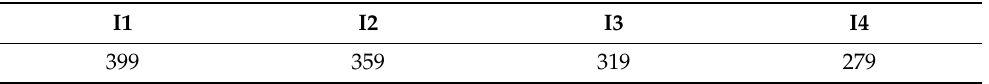
Table 2. Seasonal water consumption (mm) for tomatoes cultivated under different irrigation treat- ments (I1, I2, I3 and I4). I1